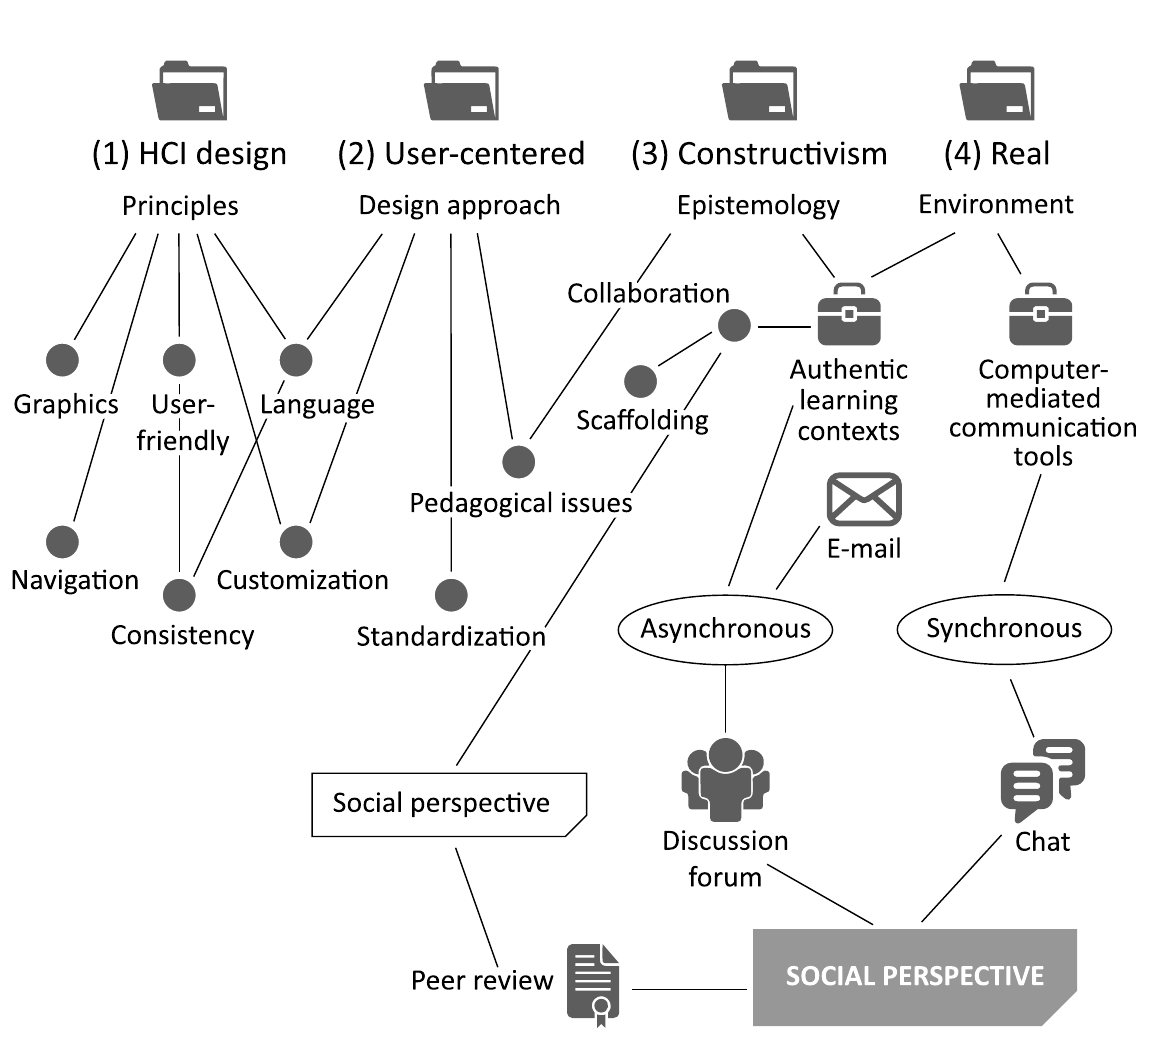
Figure 2. Proposed model for designing by constructivism, generated from research